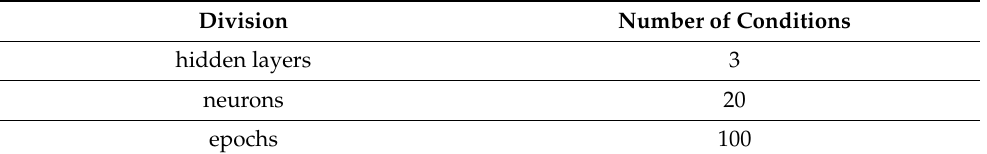
Table 1. Structural and learning parameters for multilayer shallow neural network training